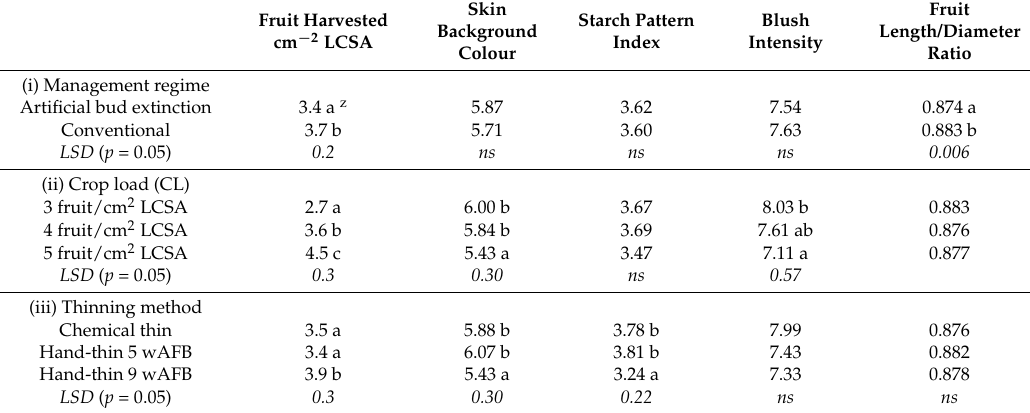
Table 6. Effect of management regime, crop load and thinning method on crop load, fruit maturity (skin background colour and starch pattern index), blush intensity and shape (length/diameter ratio) of ‘Royal Gala’ (Trial 1). LCSA = limb cross-sectional area; wAFB = weeks after full bloom. Fruit Harvested cm − 2 LCSA Colour